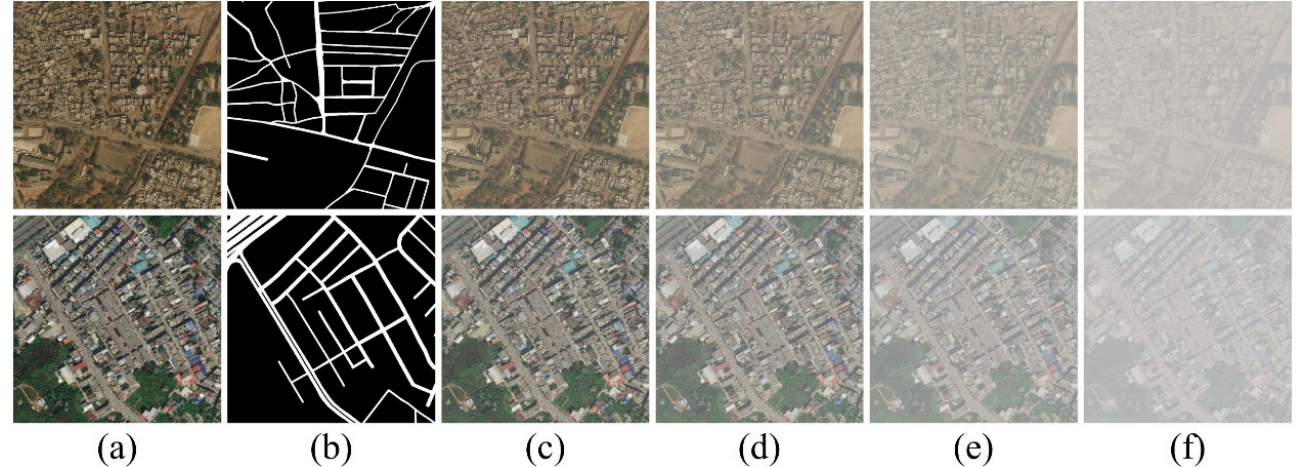
Figure 8. Samples of the generated hazy RS images from the DeepGlobe dataset [37]. ( a ) Clear image. ( b ) Ground truth road mask of image ( a ). ( c – f ) are the four generated hazy images of different densities defined as slightly hazy, moderately hazy, highly hazy, and extremely hazy, respectively.